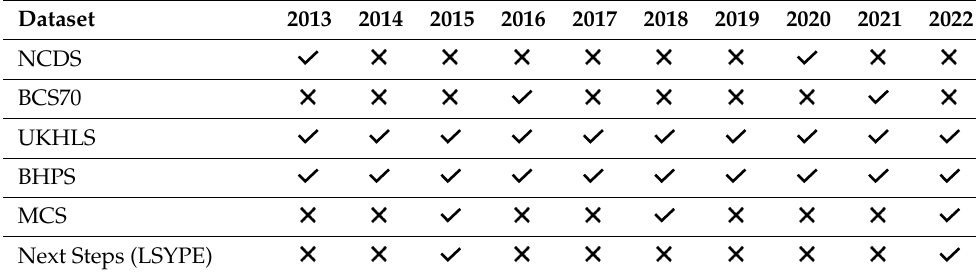
Table 3. Overview of available datasets by year.